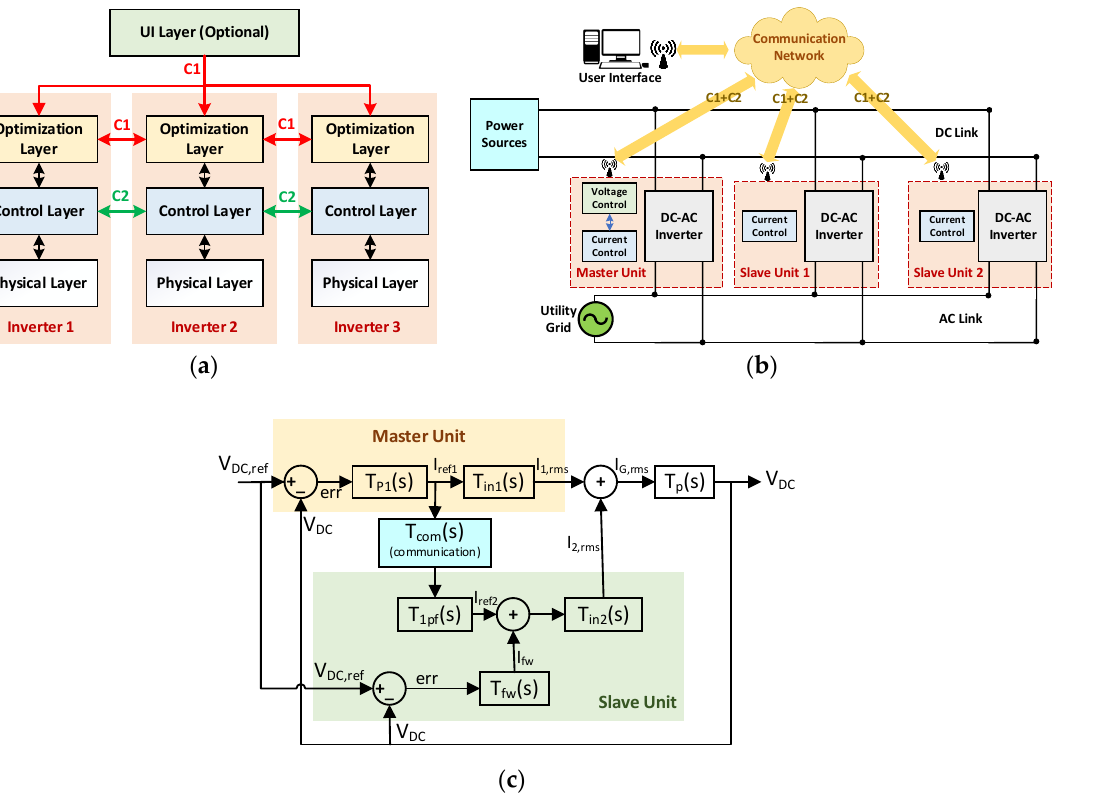
Figure 8. ( a ) A typical configuration of a parallel inverter system with two separate communication systems C1 and C2; ( b ) The LB WLcom-based method of [91]; ( c ) Control diagram of the method of [91] considering the communication impact and having the voltage feed-forward loop in the slave unit.